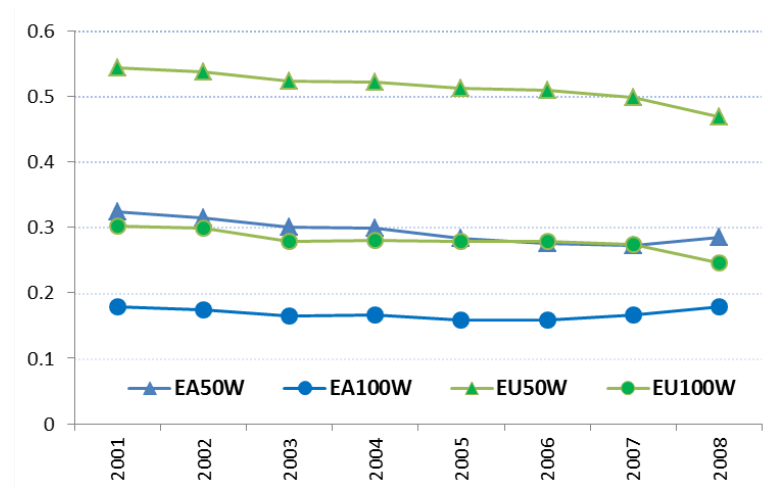
Figure 6: Moran’s I coefficients for GDP per capita for the European Union and Euro Area cross-sections